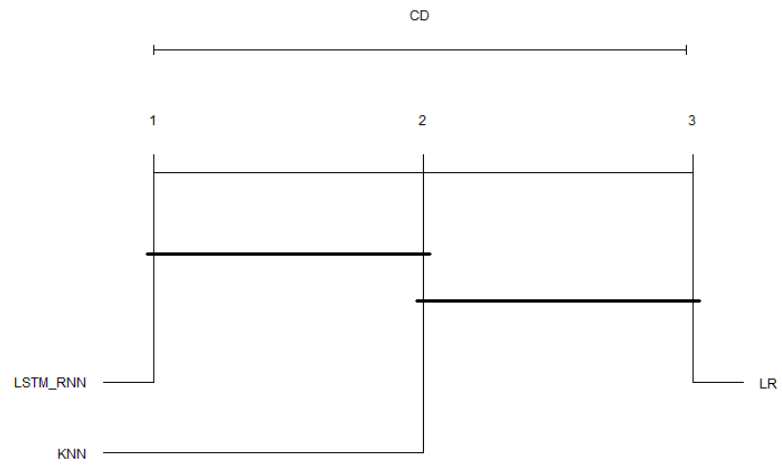
Figure 30. CDD graph for average multiclass classification.